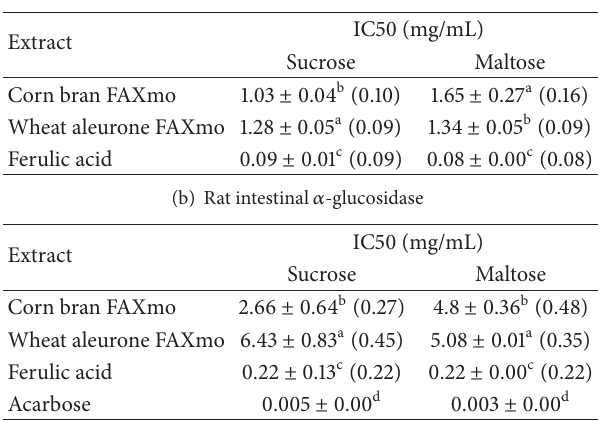
Values are presented as mean ± standard deviation ( 𝑛 = 3 for rat intestinal 𝛼 -glucosidase and 𝑛 = 6 for Caco-2 studies). Data in the same column with the same superscript are not significantly different at 𝑝 ≤ 0.05 . Data in parenthesis are IC50 values in ferulic acid equivalent (mg/mL). IC50 value is the sample concentration resulting in 50 % inhibition of 𝛼 - glucosidase activity. FAXmo means feruloylated arabinoxylan mono- and oligosaccharide